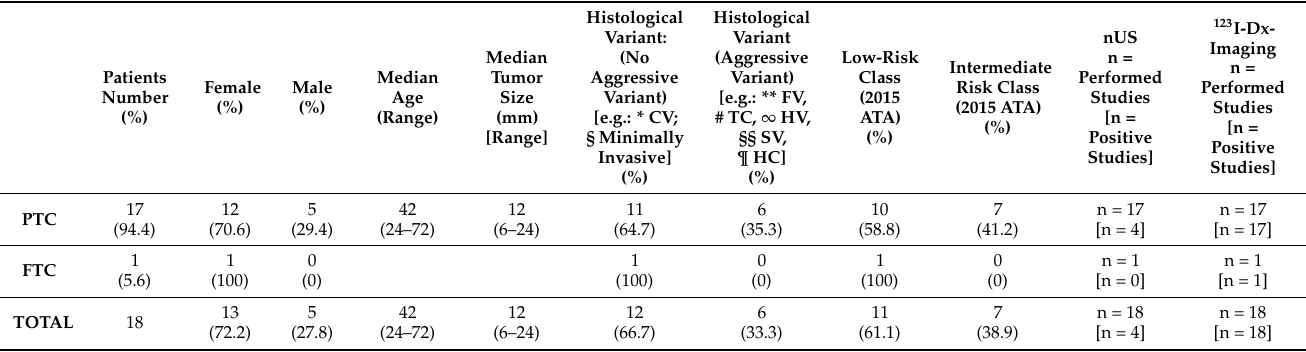
Table 4. Demographic, clinical, pathological and imaging data of the patients with structural incom- plete response (SIR) to initial treatments (Group C).